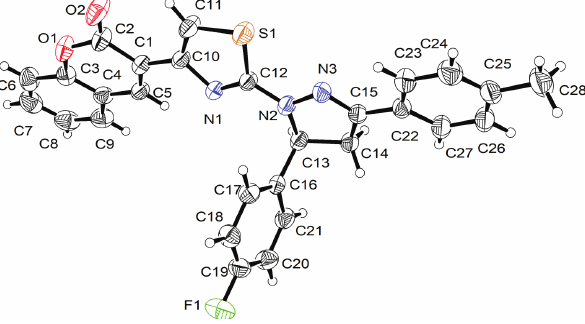
Table 1: Data collection and handling.